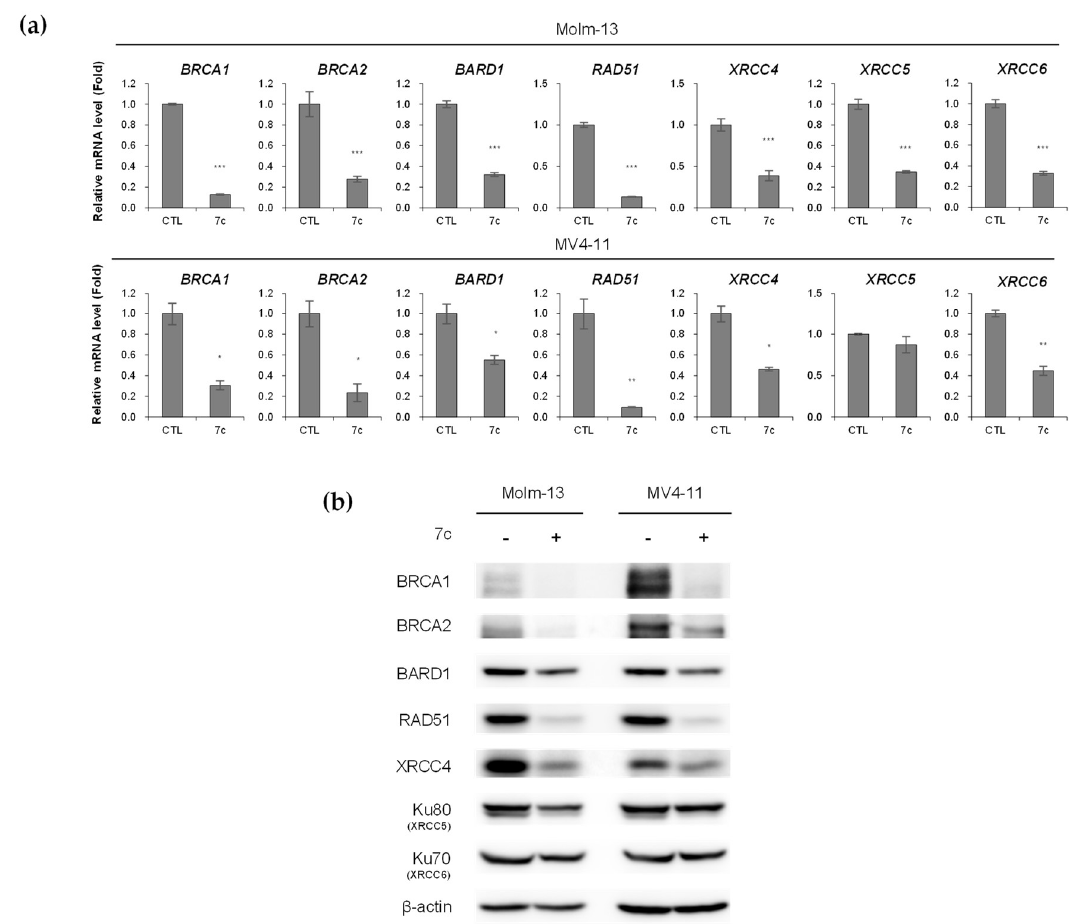
Figure 4. Compound 7c inhibited DNA damage repair. ( a ) Human FMS-like tyrosine kinase 3-internal tandem duplication-positive acute myeloid leukemia (FLT3-ITD + AML) cells (Molm-13 and MV4-11) were treated with 1 μM 7c for 18 h to quantify the mRNA expression of the indicated genes by qRT-PCR. Data are from one representative experiment that repeated in triplicate. ( b ) Cell lysates were prepared 24 h after treatment with 7c and subjected to immunoblotting for detecting the indicated proteins. as * at p < 0.05, ** at p < 0.01, and *** at p <